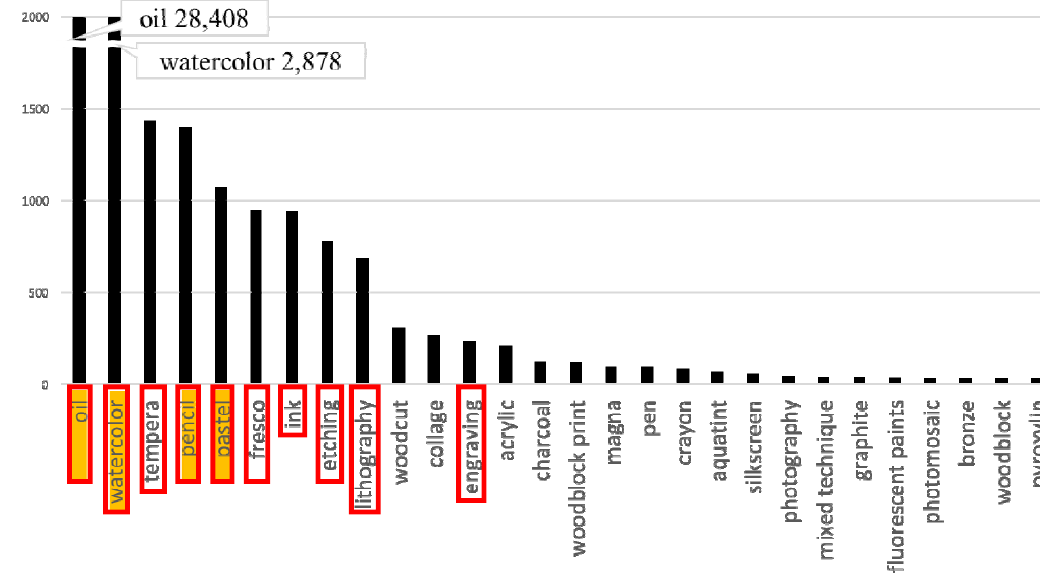
Figure 13. Frequency of the most frequently used media type from WikiArt: Yellow box denotes the media contained in YMSet+ and Wiki4, and red rectangle denotes those in